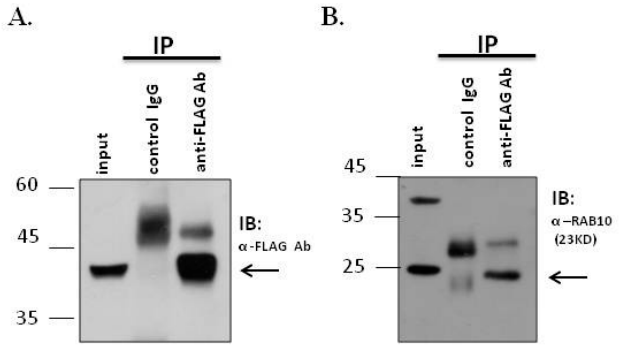
Figure 3. MGCRABGAP interacts with RAB10 in a male germ cell line; Co-IP of FLAG-MGCRABGAP with RAB10; ( A ) and ( B ) Lysates from cells transfected with pFLAG-MGCRABGAP and then immunoprecipitated with an anti-FLAG antibody (anti-FLAG Ab) or a nonspecific IgG control (control IgG), followed by immunoblotting with the anti-FLAG antibody ( A ) or anti-RAB10 antibody ( B ); Input protein (5%) was used as an immunoblotting control (input).